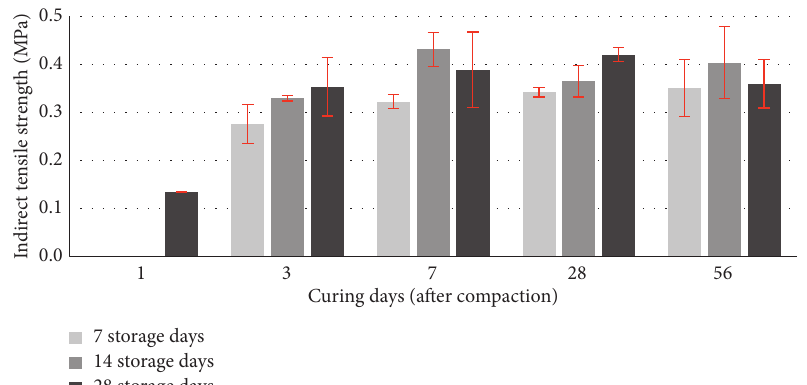
Figure 3: Tensile strength after a storage period of loose mix during 7, 14, and 28 days and curing time and compaction of 1, 3, 7, 28, and 56 days.